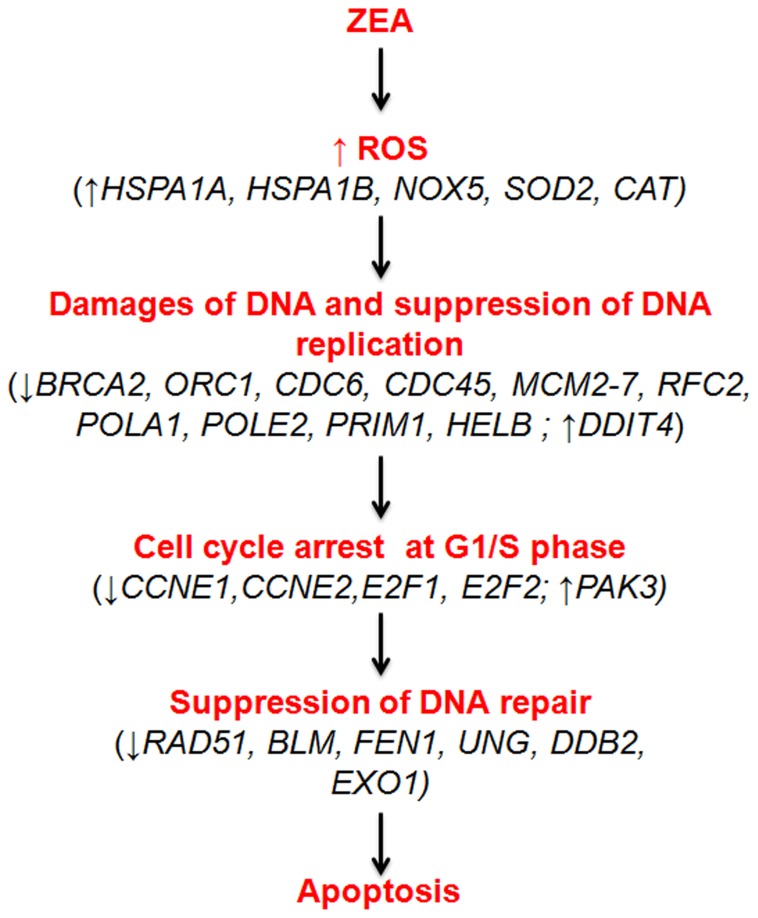
Proposed mechanisms of apoptosis induced by ZEA in BEAS-2B cells.The expression changes of genes associated with the biological processes are indicated.